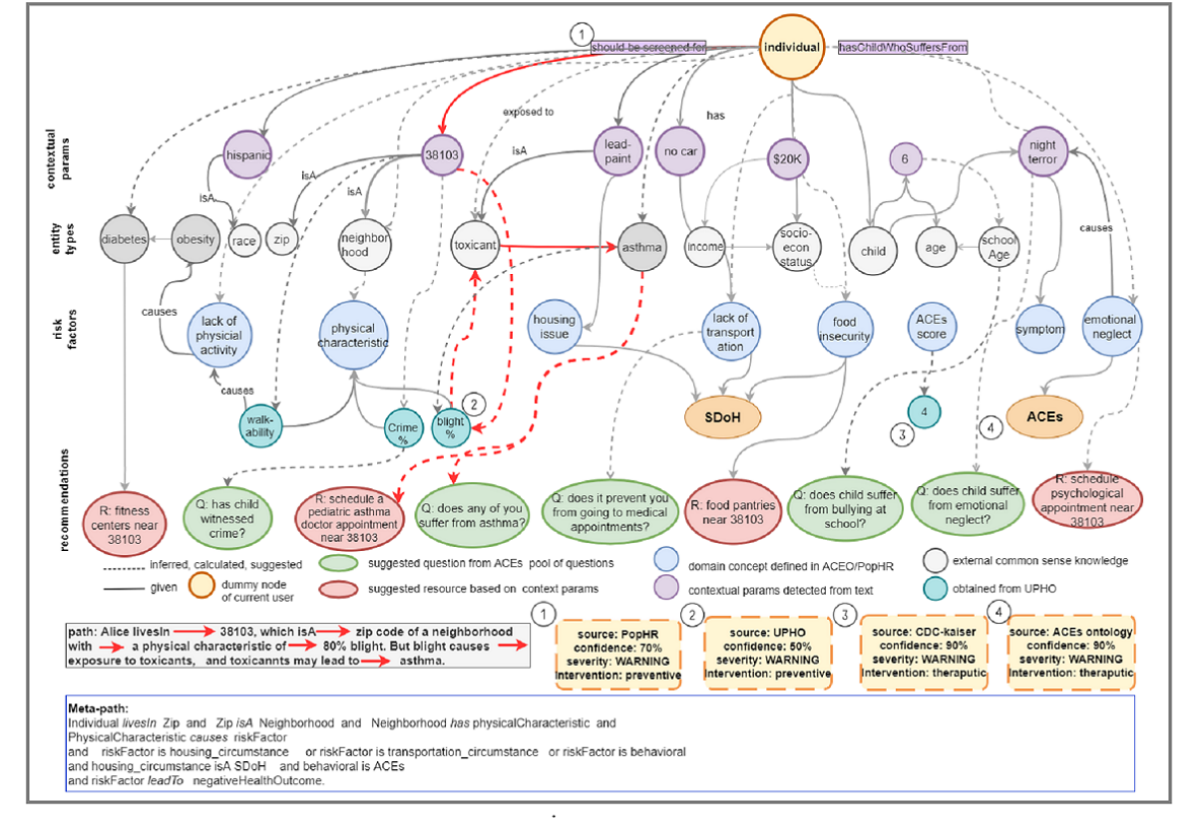
Figure 6. A personalized graph is generated based on contextual parameters provided by Alice (see Scenario 4 in Textbox 3) after populating ontology concepts with real-time contextual parameters supplied by the agent, and after enriching the graph with external common sense knowledge. The figure illustrates how a concrete path on the graph leads to a recommendation and the metapath that can be derived from that